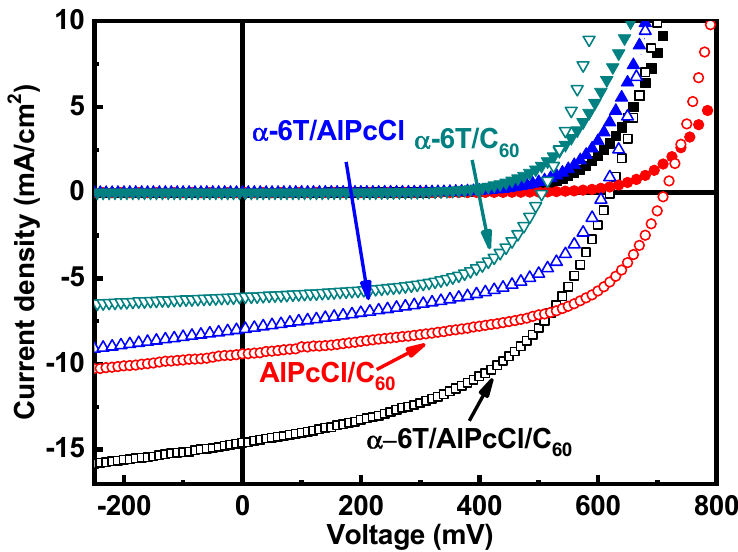
Figure 2. J-V characteristics of binary and ternary PHJ-OPVs: ITO/MoO 3 /active layers/Alq3/Al, the active layer being AlPcCl/C 60 ( ● ), α -6T/C 60 ( ▼ ), α -6T/AlPcCl ( ▲ ) and α -6T/AlPcCl/C 60 ( ■ ), (the filled symbols correspond to dark conditions, while the empty symbols correspond to light AM 1.5 conditions). Table 2. Parameters of the PHJ-OPV family using α -6T, AlPcCl and C 60 .